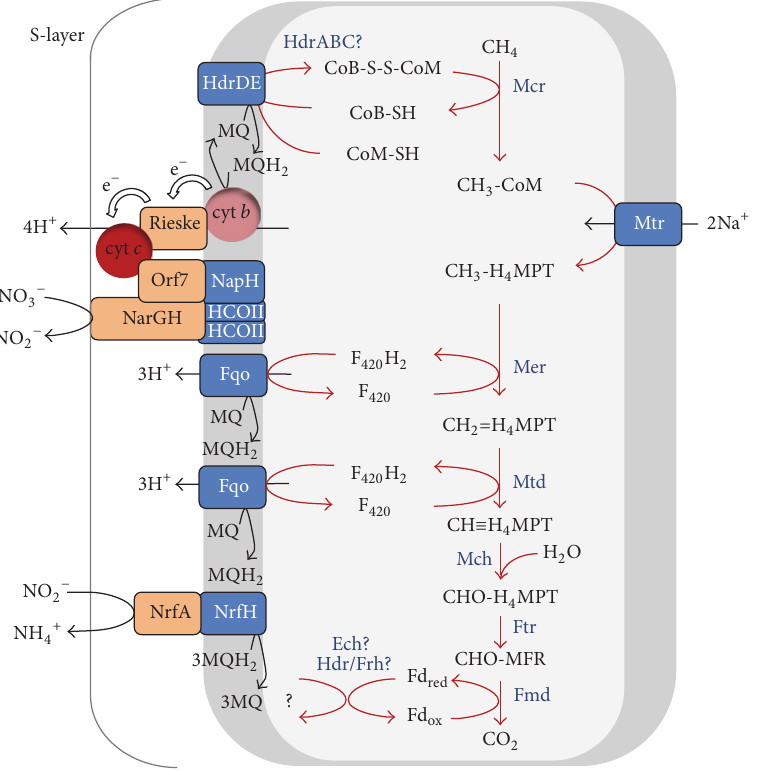
Figure 5: Methanotrophic pathway during N-AOM by “ Ca. M. nitroreducens” MPEBLZ (ANME-2d) [43]. Red lines indicate reversal of the hydrogenotrophic methanogenic pathway. See Table 3 for